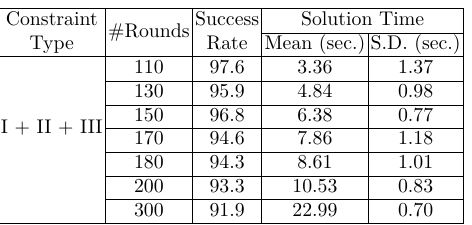
Table 4: Success rate of MILP model for